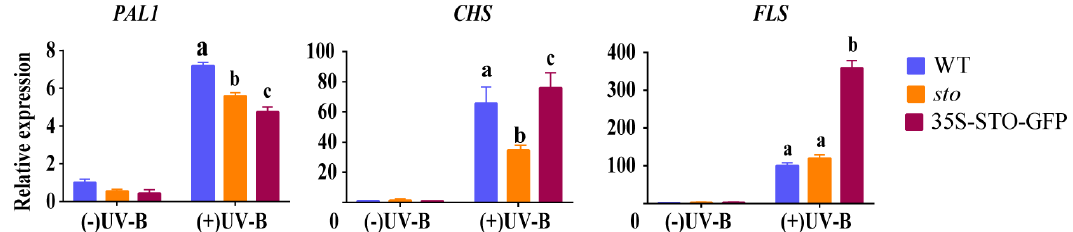
Figure 7. Expression profile of genes involved in flavonoid synthesis before and after UV-B treatment. The WT, sto, and 35S-STO-GFP seedlings were grown in white light for seven days and then subjected to a four-hour UV-B treatment (0.6 W/m 2 ). Error bars indicate the SEM of three independent biological and technical replicates. Different letters indicate significant differences between gene relative expressions of those seedlings grown under UV-B radiation ( P < 0.05, Dunnett’s multiple). Actin2 was used as an internal reference gene.